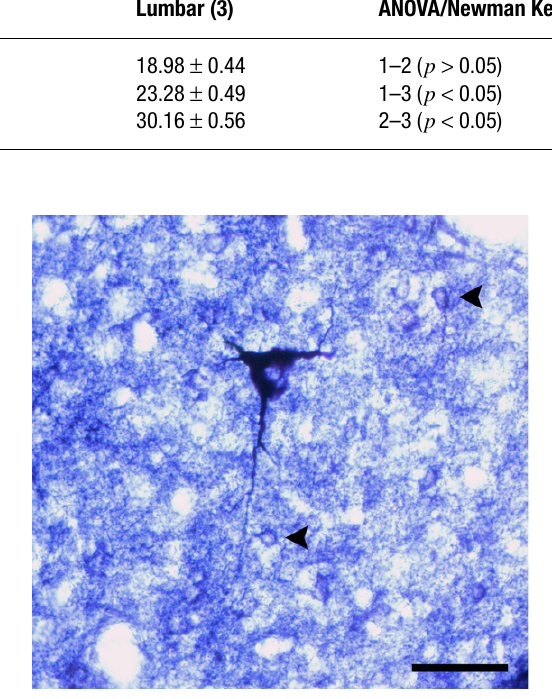
tral canal of the lumbar segment in agouti’s spinal cord. Note both the small size of the cell body and the weakly stained dendritic arbor of type II neurons (arrowheads) when compared to the much-larger type I cell. Scale bar: 30